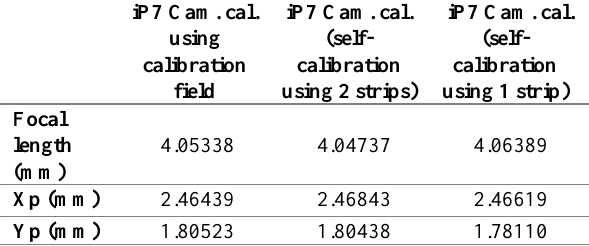
Table 3. Camera calibration parameters estimated